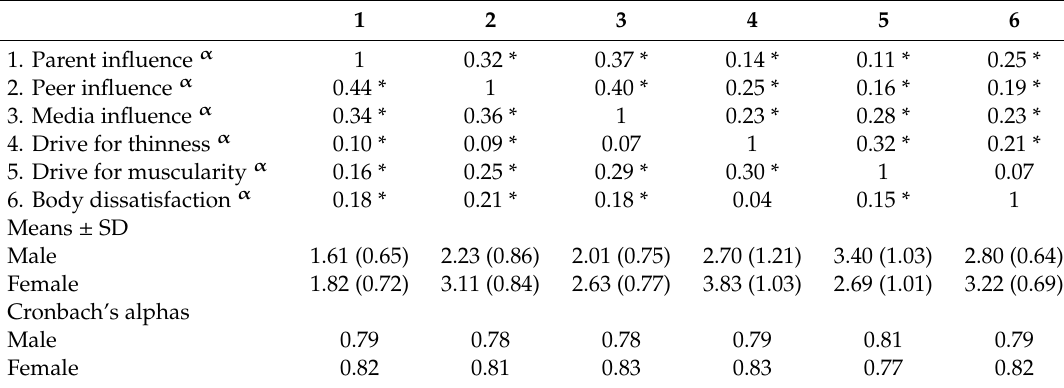
Table 1. Correlations and descriptive statistics for study